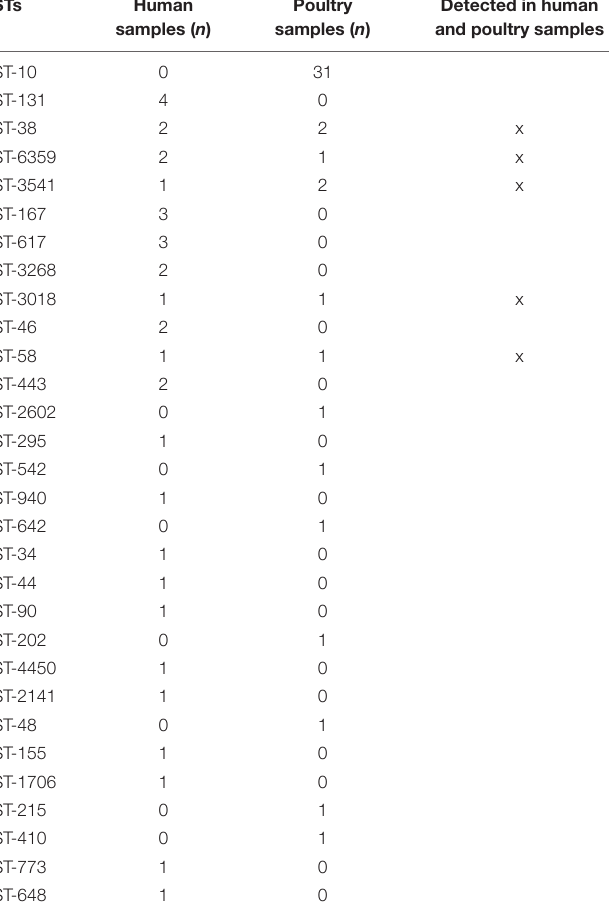
TABLE 1 | Frequency of sequence type (ST) in human and poultry samples (sorted by ST frequency). STs Human Poultry Detected in human samples ( n ) samples ( n ) and poultry samples